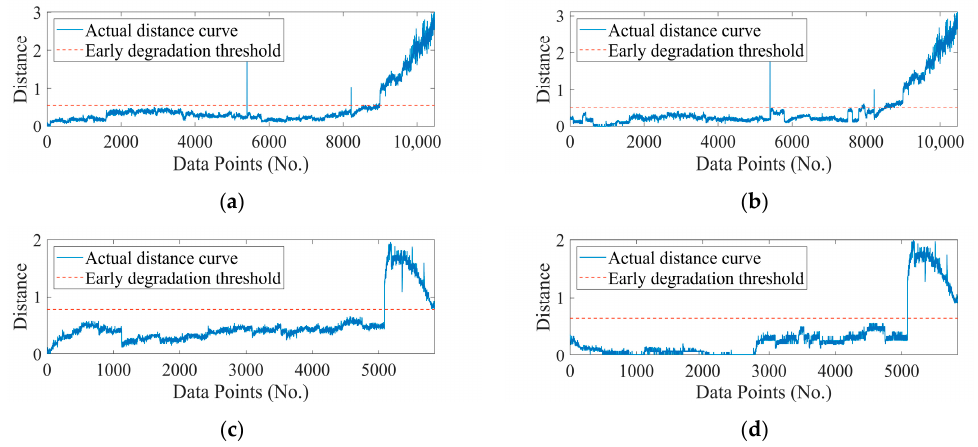
( b ) Figure 15. Changing rates of RMS: ( a ) Dataset 1, ( b ) Dataset 2 Table 8. Results of OHS selection. Dataset Total Quantity of Samples Quantity of Samples Put into the SOM Network Sample Located in the Clustering Center of SOM Network